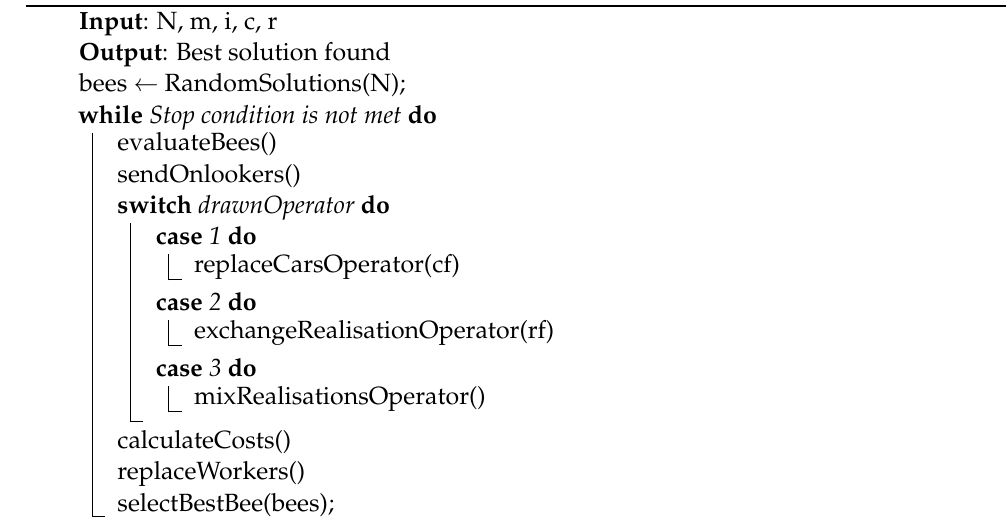
Algorithm 2: Artificial Bee Colony